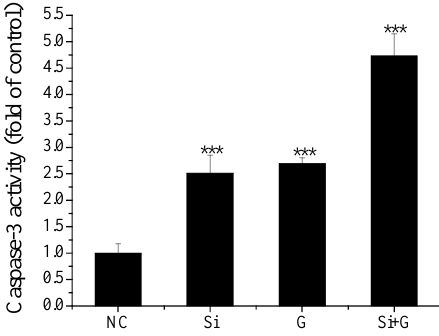
Figure 8. Effect of SelR gene knockdown on D -galactose-induced caspase-3 activity. Data are the mean ± SD of at least three independent experiments. *** p < 0.001, compared to the negative control group. NC: negative control cells; Si: cells with SelR siRNA transfection for 24 h; G: cells exposed to D -galactose (150 mM) for 36 h; Si+G: cells with SelR siRNA transfection followed by D -galactose exposure.